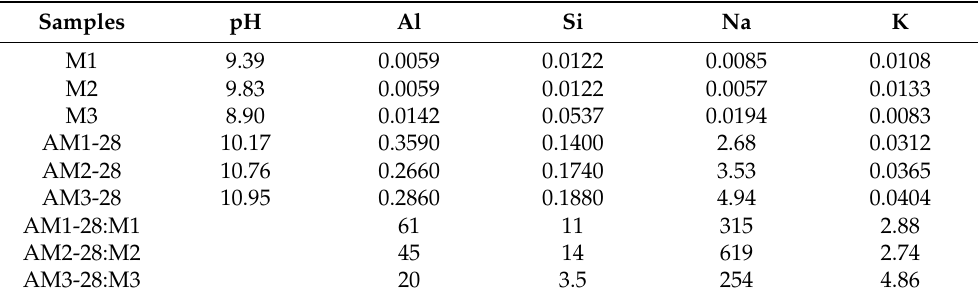
Table 3. Metakaolins and alkali-activated metakaolins AM-28: elements (wt. %) leached at pH in distilled water.